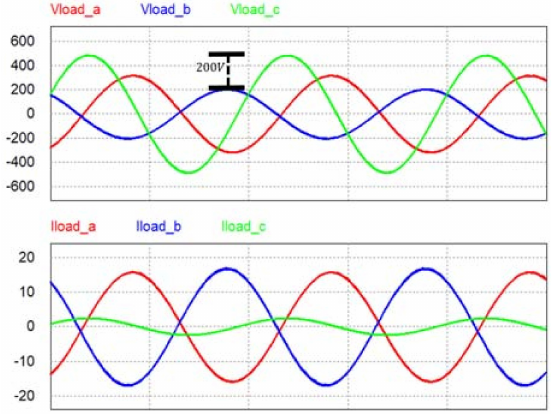
Figure 9. Simulation results of the five-limb core-type transformer (conventional proportional-integral (PI) controller).